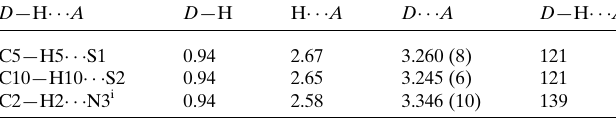
Table 2 Hydrogen-bond geometry (A˚ , (cid:5) ).